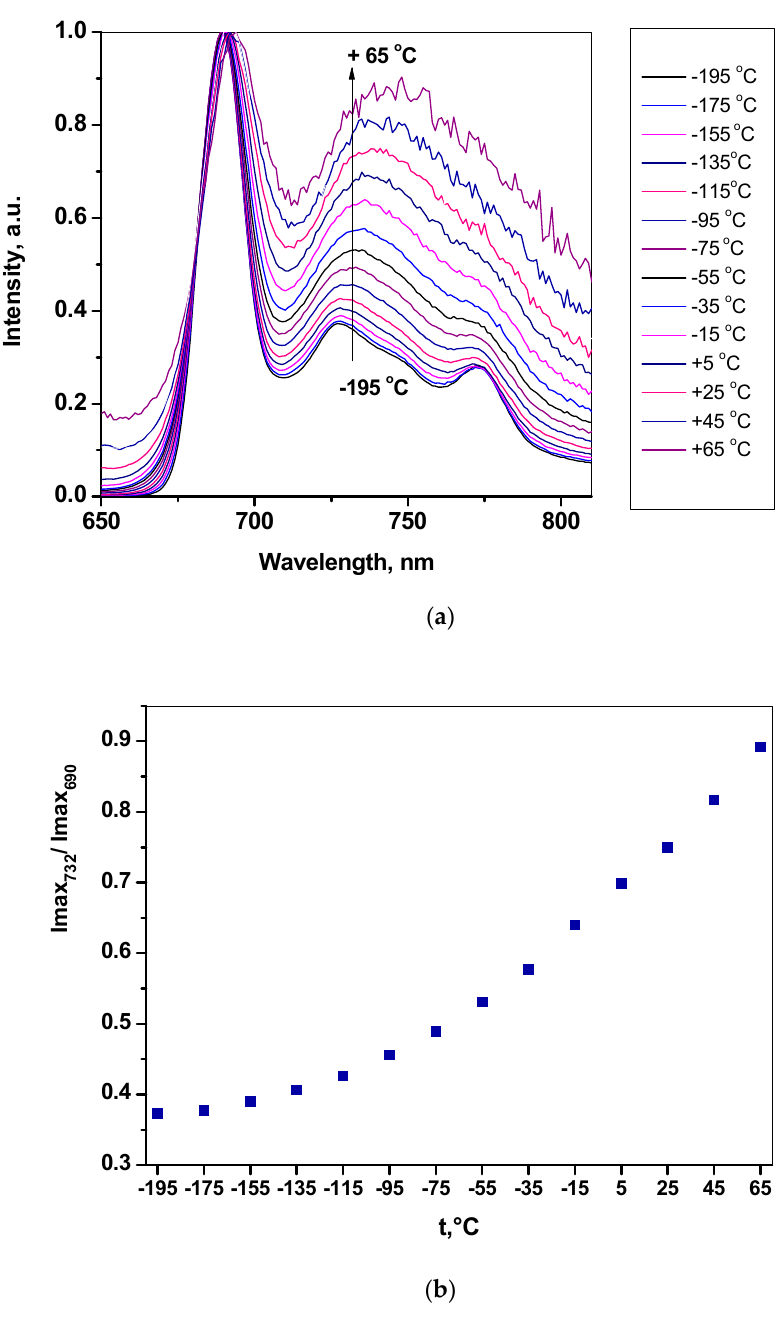
Figure 2. Temperature dependence of photoluminescence spectra for Cu-EtioP in polystyrene film. ( a ) The spectra measured using a Linkam cryostat with a 20 °C interval from − 195 °C to 65 °C; ( b ) Temperature dependence of the PL intensity ratio ( I 732nm /I 690nm ) at band maxima. However, when the sample is cooled to − 195 ◦ C, the spectrum becomes better resolved and the ratio of the intensities of the main maxima changes significantly. This can be explained by the different temperature dependence of the rate constants of the radiative transitions from the trip-doublet 2 T 1 and trip-quartet 4 T 1 electronic levels to the main sing-doublet level 2 S 0 (Scheme